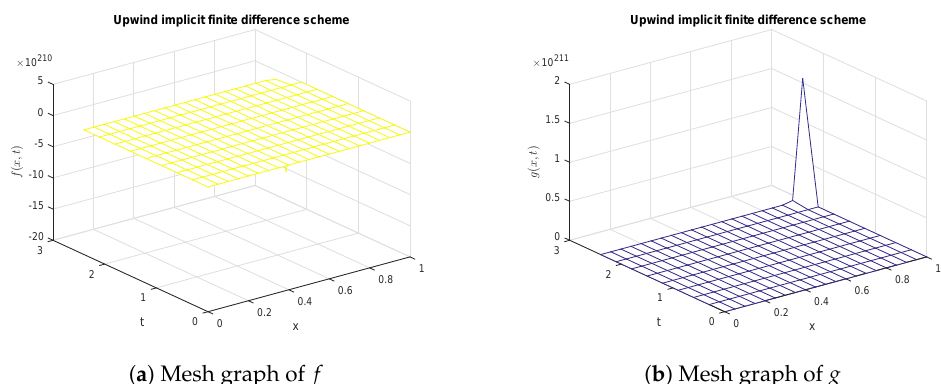
Figure 4. Graphical solution of f , g (concentration of substances) using upwind implicit method at a = 3.5, b = 0.25, χ 1 = 6, χ 2 = χ ∗